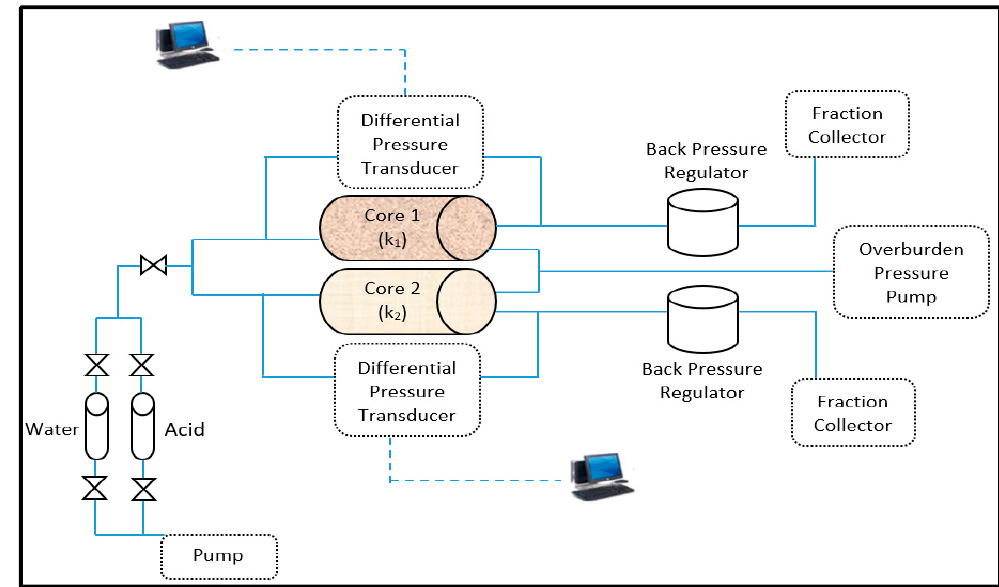
Figure 20. A schematic of the parallel coreflood setup.